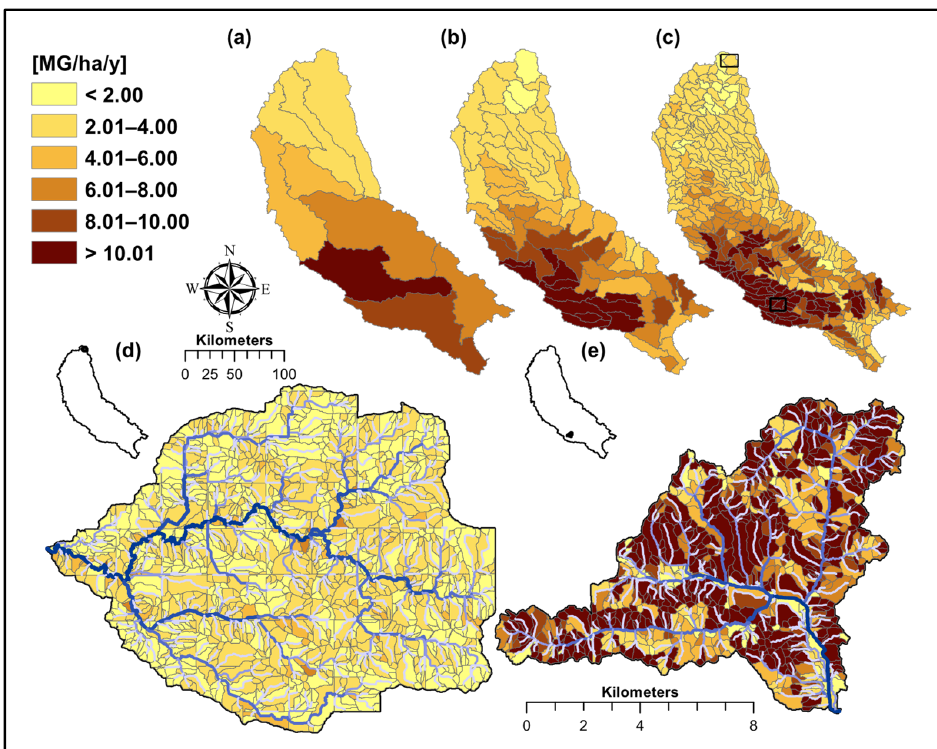
Figure 9. Example of aggregation of annual average total suspended sediment yield per unit of area converted to sub-basin—HUC08 ( a ), watershed—HUC10 ( b ), and sub-watershed—HUC12 ( c ) from field scale—AnnAGNPS cells ( d , e ).